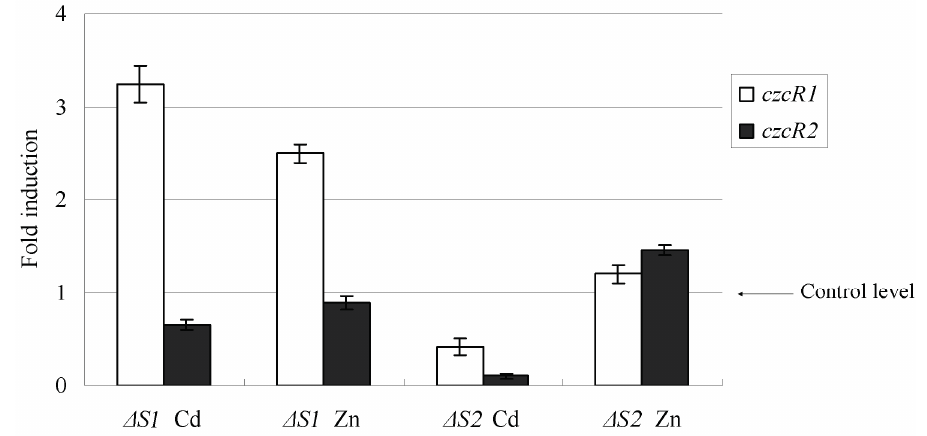
Figure 4. The effects of the mutation in czcS1 and czcS2 on the transcription of czcR1 and czcR2 . Transcription of czcR1 and czcR2 was analyzed by qRT-PCR in the wild-type X4 strain and mutant strains grown with 300 μ M Zn 2+ or Cd 2+ . The amount of mRNA is represented relative to the wild-type X4 strain cultivated in the same concentration of metal ions. Error bars represent the standard deviations of three